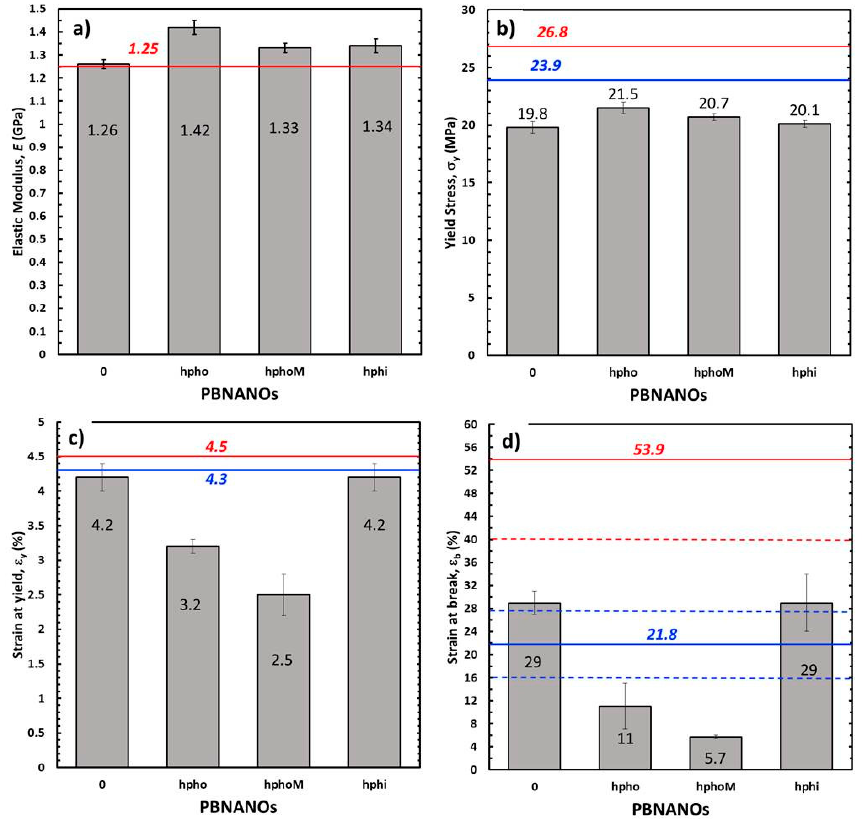
Figure 16. Mechanical tensile parameters obtained for the materials under study. ( a ) Elastic modulus (E); ( b ) yielding stress ( σ y ); ( c ) deformation at yield ( ε y ) and ( d ) elongation at break ( ε b ). Horizontal solid lines represent the upper (red) and the lower (blue) limits of the additive mixing law. The dashed lines in ( d ), represent their respective error bands.